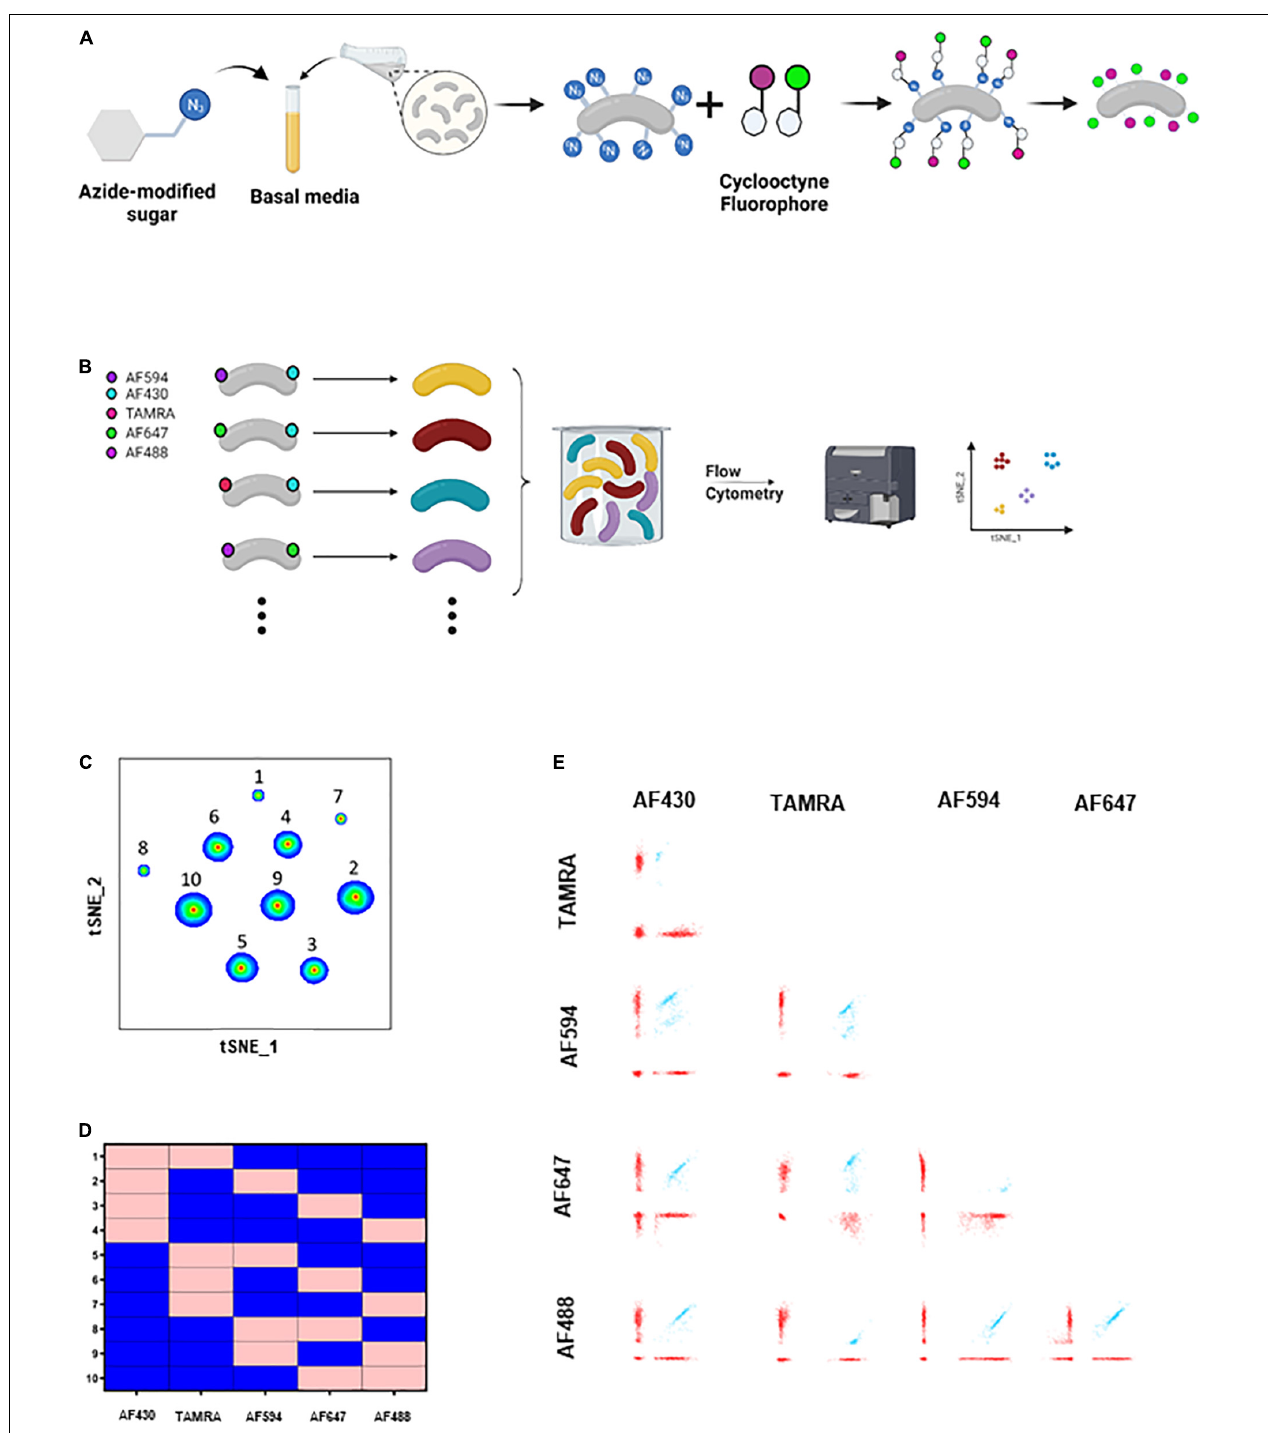
FIGURE 1 | COMBICK dual labeling with 5 fluorophores allows differentiation of up to 10 bacteria at once. (A) Schematic representation of the metabolic labeling procedure. Bacteria are grown in the presence of azide-modified sugars and subsequently are incubated with a cyclooctyne tagged fluorophores which covalently react with the azide group turning the bacteria fluorescent. (B) Schematic representation of the COMBICK method. Metabolic labeling of each bacteria with a combination of fluorophores results in a unique label that enables the differentiation of specific populations of bacteria in communities. Combinatorically labeled bacteria can be analyzed by downstream applications (e.g., flow cytometry). (C) t-SNE plot of flow cytometry analysis of a mixture of B. longum bacteria labeled with 10 different dual combinations. (D) Matrix demonstrating the dual label of each of the 10 B. longum populations identified in panel (B) and analyzed by flow cytometry. Pink represents positive labeling and blue negative. (E) Flow cytometry dot plots of the 10 different clusters of B. longum identified in panel (C) .